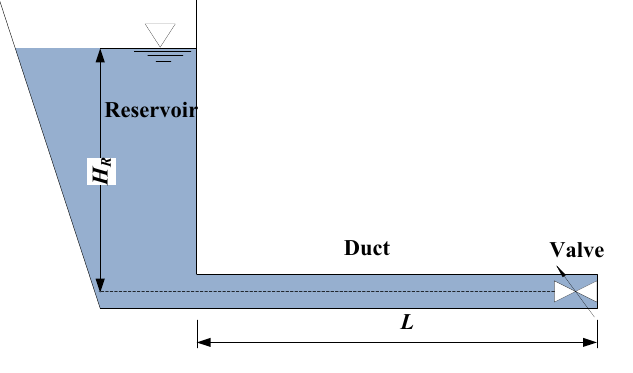
Figure 2. A reservoir-pipe-valve